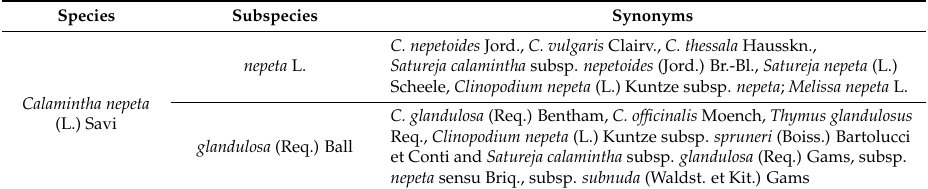
Table 1. Calamintha nepeta (L.) Savi, its subspecies and the most common synonyms. Species Subspecies Synonyms nepeta Calamintha nepeta (L.) Savi